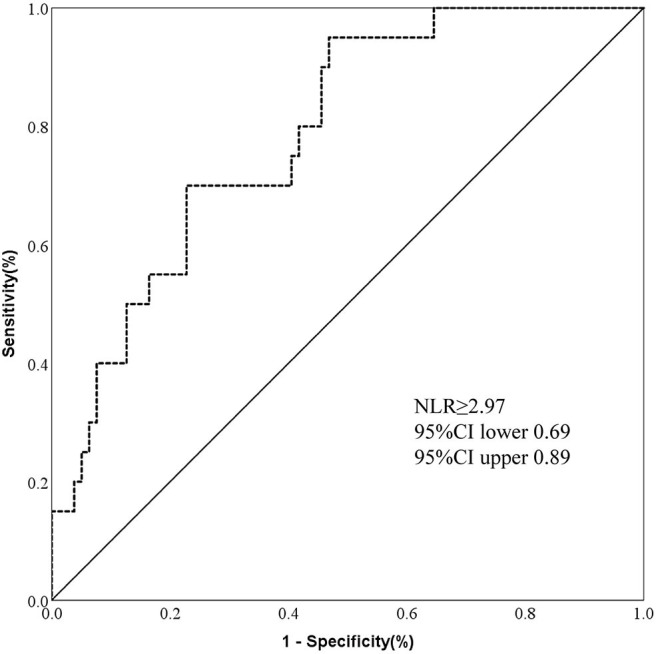
ROC showed predictive value of NLR for 3-month poor outcome in AIS by CCAD. [n = 99; sensitivity = 0.95; specificity = 0.53; NLR = 2.97; area under curve (AUC) = 0.79].